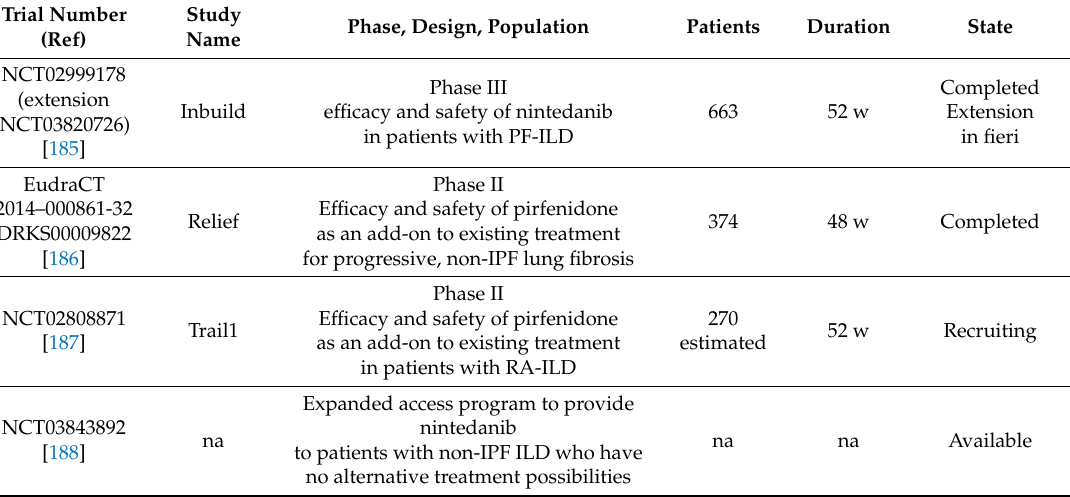
Table 8. Clinical trials of antifibrotic agents for the treatment of fibrosing ILDs other than IPF, including patients with